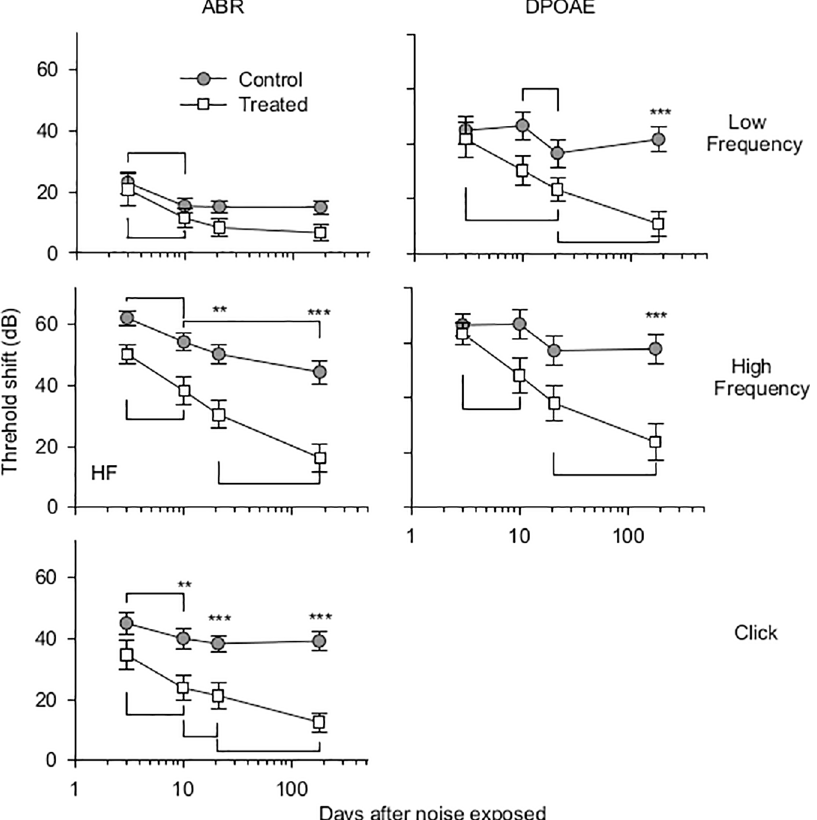
Fig 2. Time course of in-group ABR and DPOAE threshold shifts. The mean and SEM (vertical bars) for “click” (CLK), low frequency(LF), 0.5 and 2 kHz; and high frequency (HF), 2, 4, 6, 8 kHz ABR data were plotted for each time point. Two-way ANOVA and Bonferroni Post Hoc test were applied.The symbols of ** and *** indicatesignificantdifferences of p < 0.01and0.001, respectively. Horizontalbars indicatesignificant differences of p < 0.05. Both the ABR and DPOAE threshold shifts of the HPN-07-treated group was significantly less than the untreatedgroup at all recordingintervals.